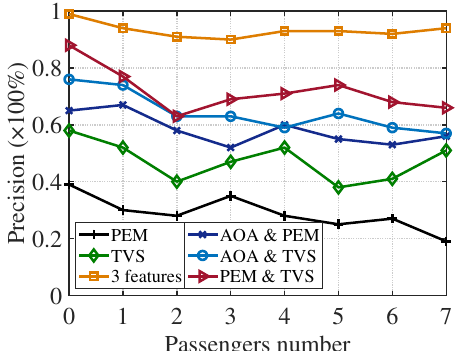
Figure 10. Precision comparison of different